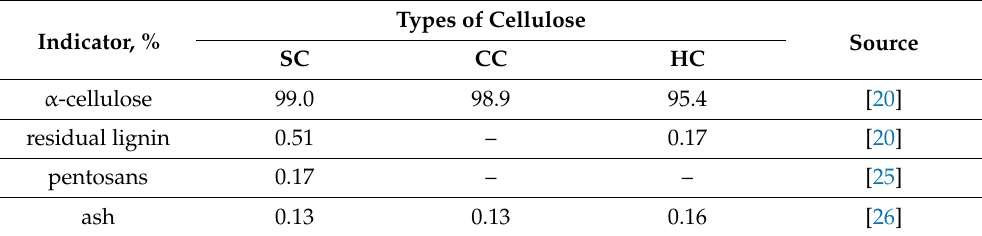
Table 1. Characteristics of several cellulose types. Indicator,